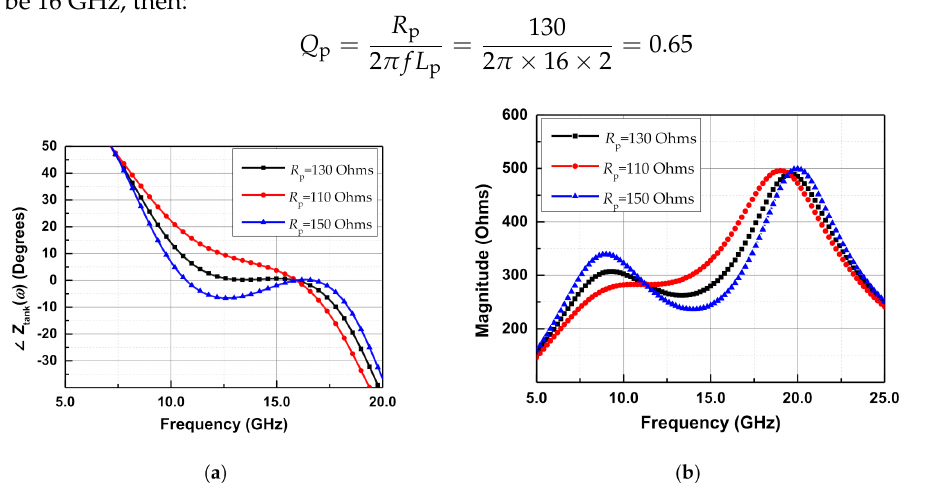
Figure 7. ( a ) Phase responses according to variations of R p . ( b ) Magnitude responses according to variations of R p .